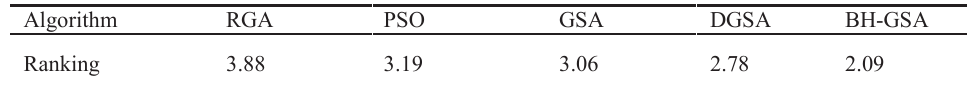
Table 11. Average ranking of algorithms based on the average best-so-far for multimodal test functions of set 1. Algorithm